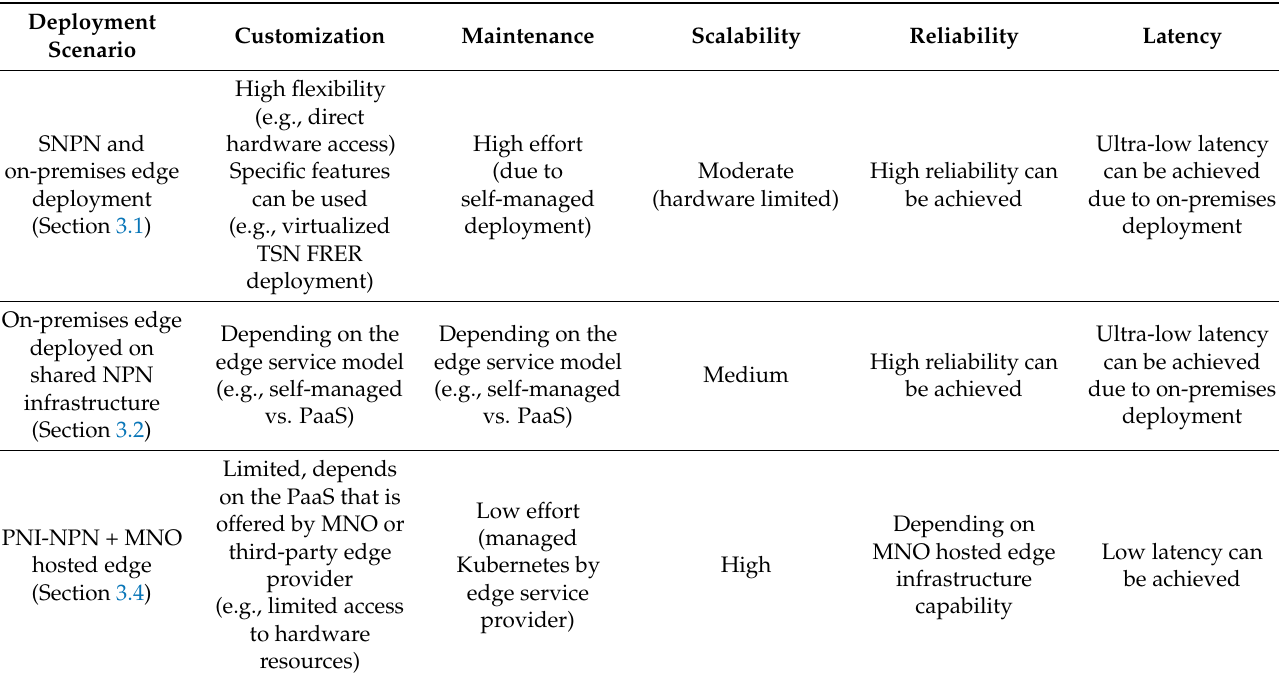
Table 2. Main characteristics of the integration scenarios of NPN deployment models and edge computing options.